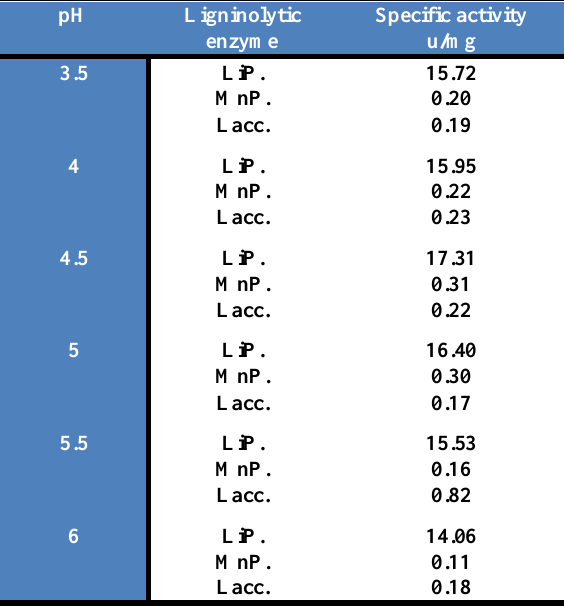
Table, 9: Ligninolytic enzymes production by use different initial pH of medium.